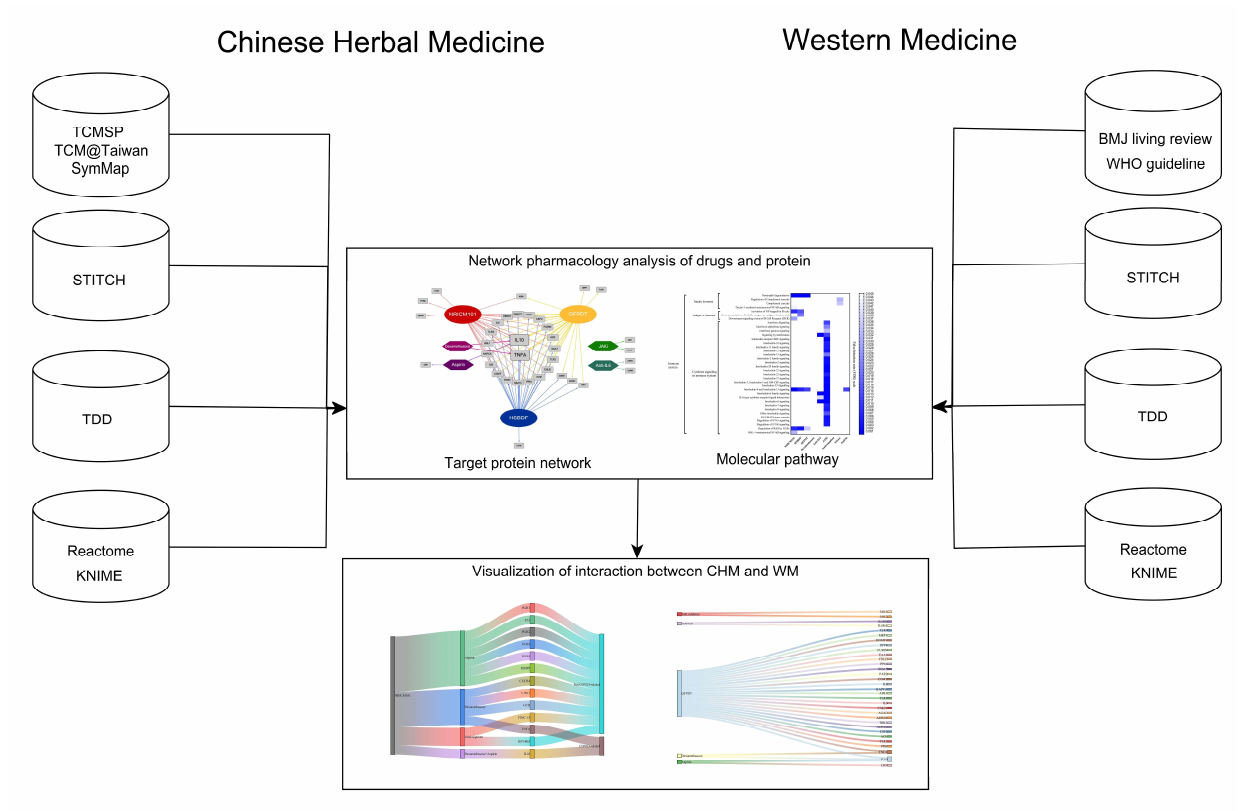
Figure 8. Flow diagram of this